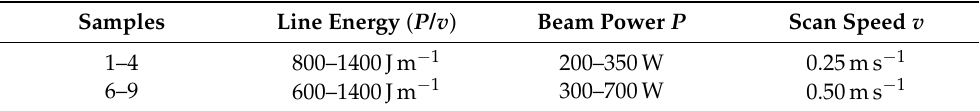
Table 3. The beam parameters for the single-line experiments. The line-energy stepping was 200Jm − 1